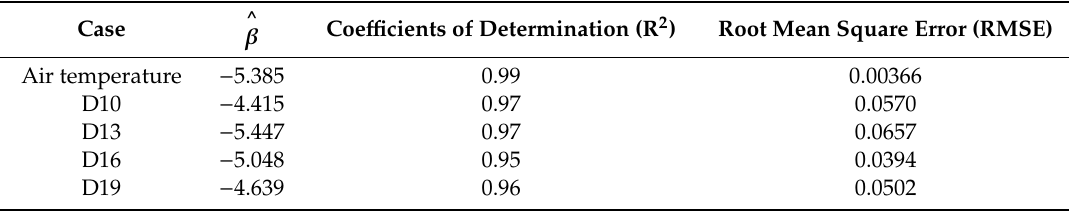
Table 2. The Gaussian process regression (GPR) fitting